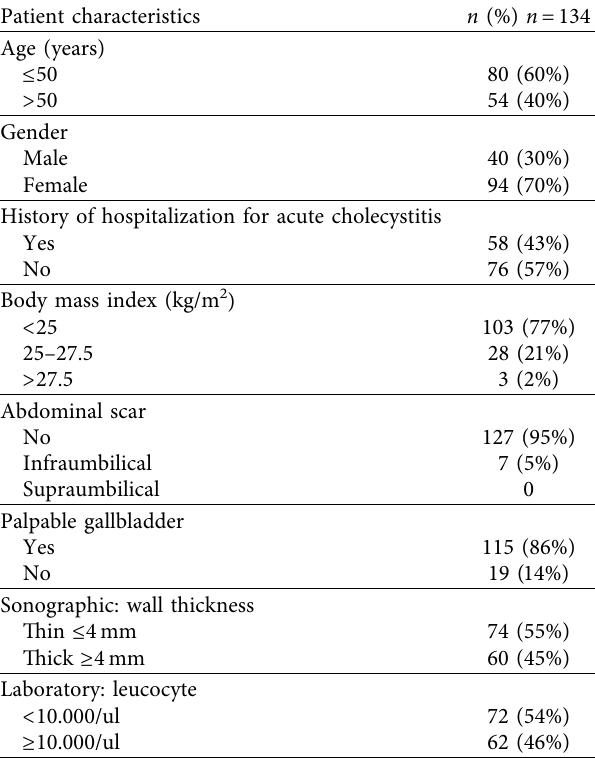
Table 4: Preoperative characteristics of the study